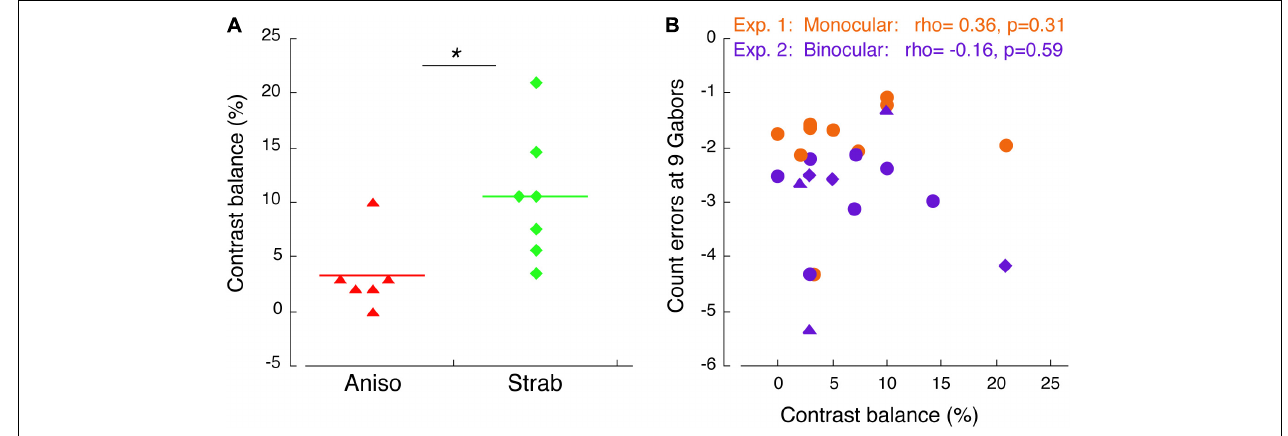
FIGURE 5 | Correlation of counting performance and contrast balance. (A) Contrast balance between anisometropic and strabismic amblyopes. * denotes p < 0.05. (B) Correlation of counting error at 9 Gabors and contrast balance in Experiment 1 (orange) and Experiment 2 (purple). Triangles indicate anisometropic amblyopes and diamonds indicate strabismic amblyopes, who also participated in Experiment